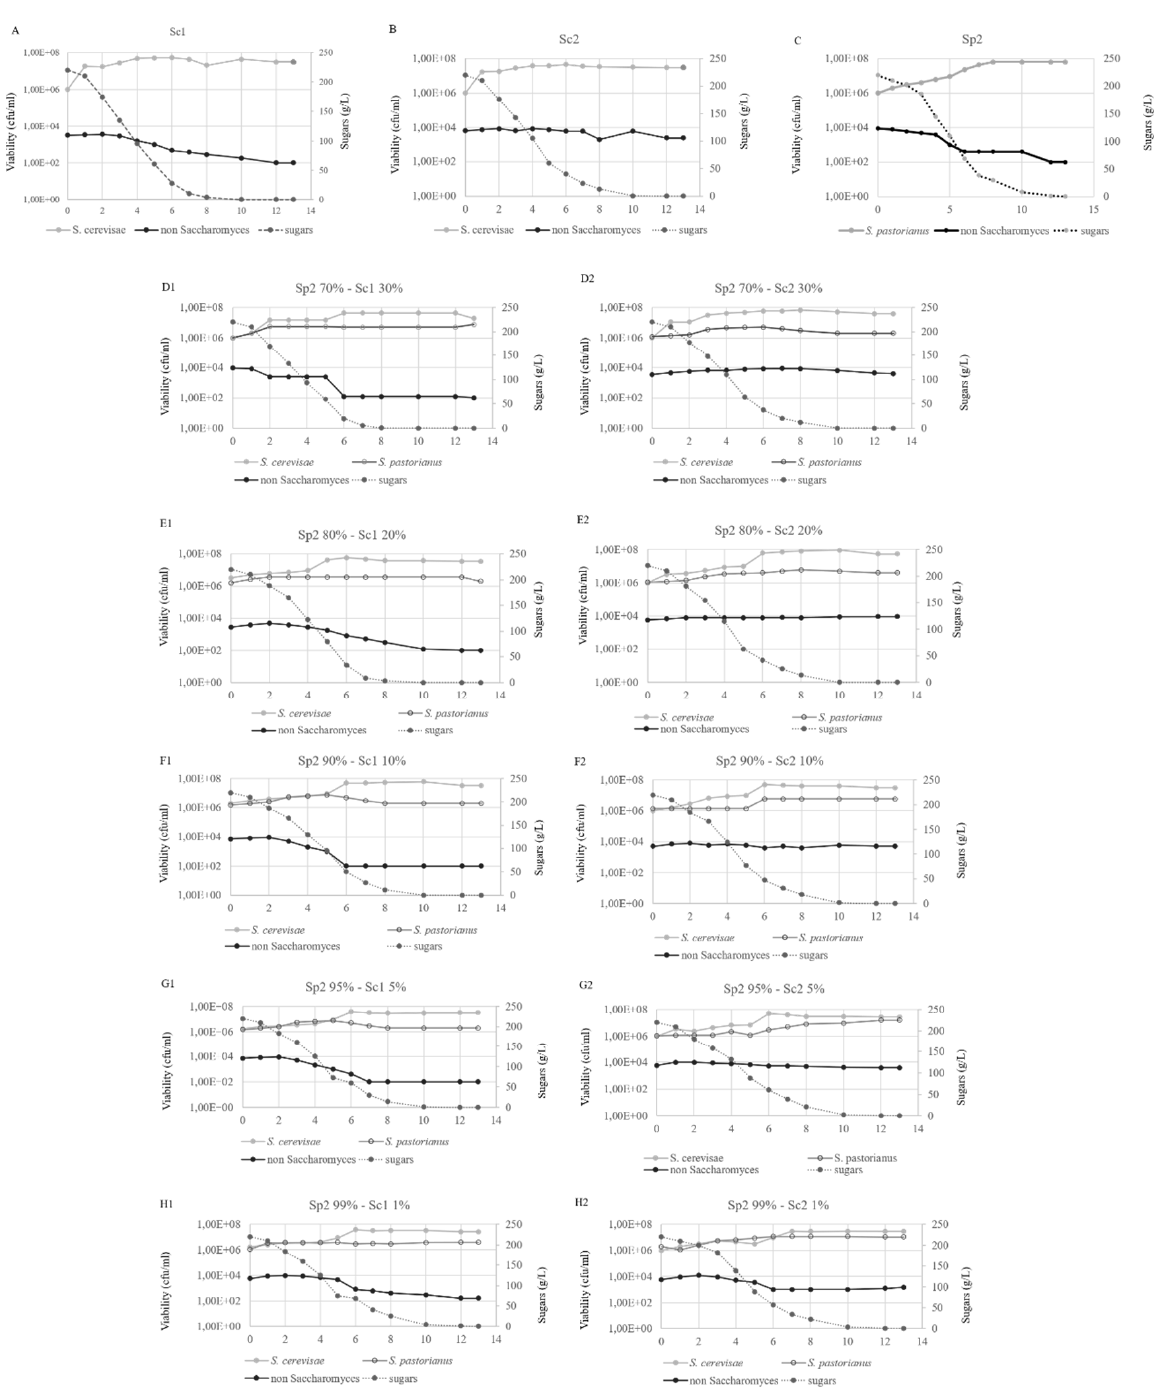
Figure 1. Fermentation kinetics and yeast population dynamics of Sauvignon blanc must which was inoculated with pure ( A – C ) and mixed ( D – H ) cultures of Saccharomyces species. The S. cerevisiae - inoculated strains (Sc1 and Sc2) are indicated with grey lines, and the S. pastorianus -inoculated strains (Sp2) are indicated with white circles, while the indigenous wild yeast is indicated with black lines. The fermentation follow-up through sugar consumption is indicated with a dashed line. Values are means of two independent experiments.